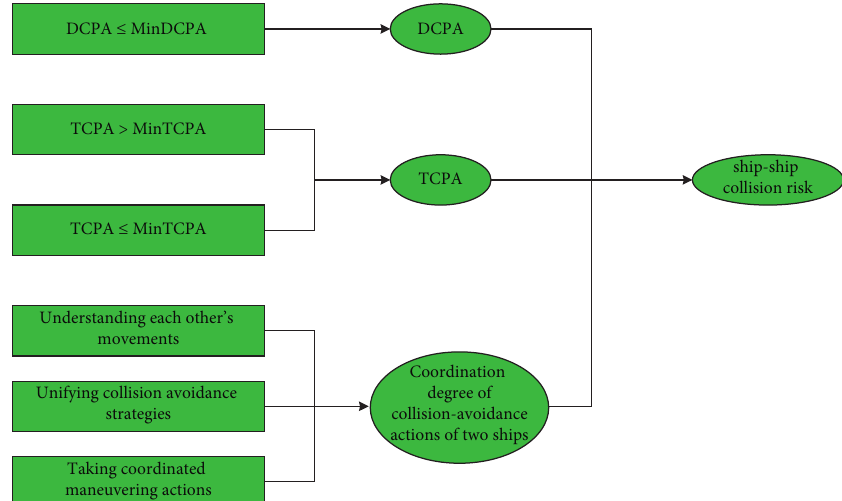
Figure 10: Early warning model framework proposed for inland-waterway ships.